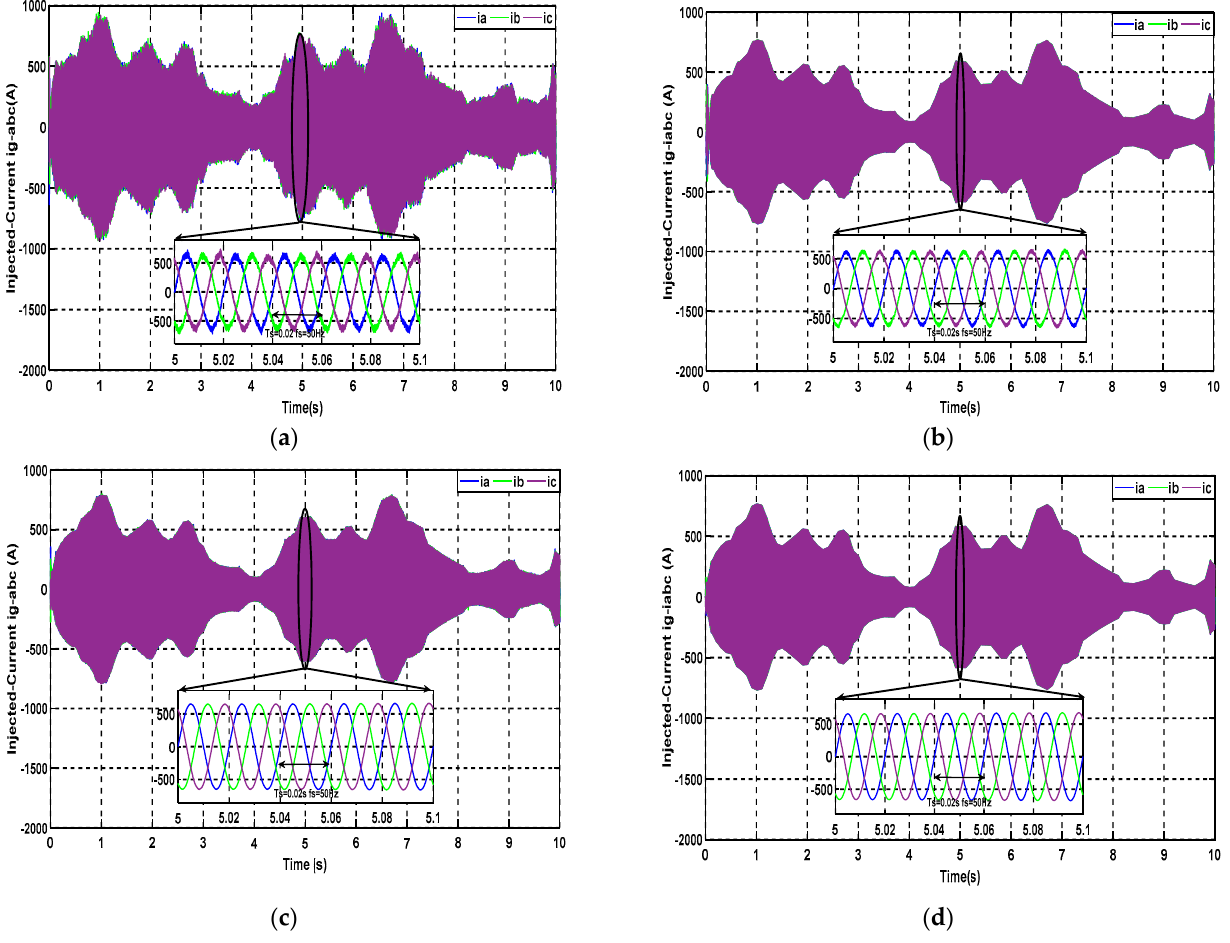
Figure 19. Injected current i g-abc by: SMC ( a ); DPC ( b ); BSC ( c ); MPC ( d ).